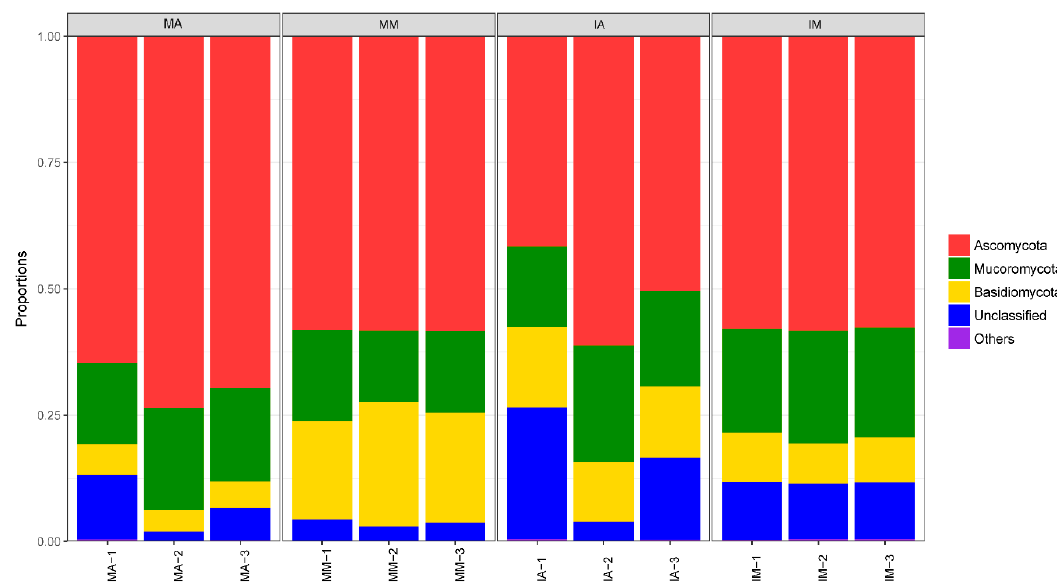
Figure 2. Influence of plant types and planting pattern on the fungal community structure at phyla level in the rhizosphere soil. The dominant phyla were Ascomycota , Mucoromycota , and Basidiomycota in all soil samples. Comparative analysis of monoculture and intercropped treatments revealed a distinct distribution of the fungal phyla. Notes: MM, IM, MA, IA represent monoculture mulberry, intercropped mulberry, monoculture alfalfa, and intercropped alfalfa, respectively. MM-1, MM-2, and MM-3 represent three repeats of MM, IM-1, IM-2, and IM-3 represent three repeats of IM, MA-1, MA-2, and MA-3 represent three repeats of MA, IA-1, IA-2, and IA-3 represent three repeats of IA.